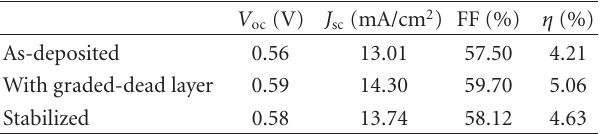
Figure 5: Schematic structure of the p-i-n solar cell with double graded-dead nc-SiGe i-layers and I-V characteristics of the solar cells without (as-deposited), with double graded-dead absorption layer, and after light-soaking test for 500 h. Table 2: The external parameters of nc-SiGe thin film solar cells without (as-deposited), with double graded-dead i-layers, and after light-soaking